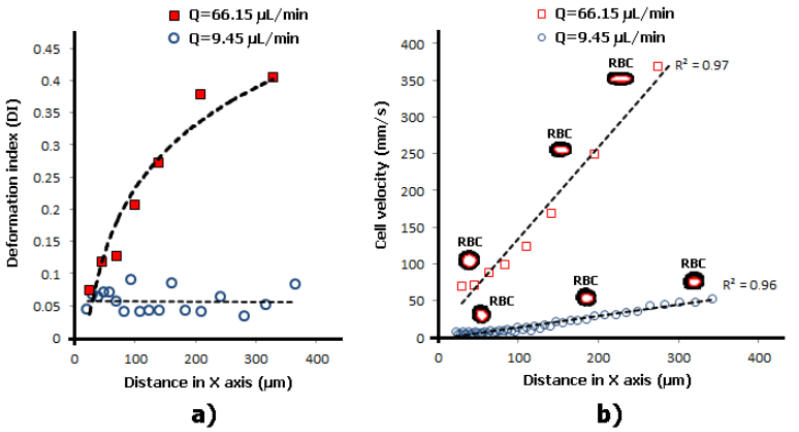
Figure 4. Individual RBCs’ ( a ) DI and ( b ) velocity flowing through a hyperbolic contraction microchannel for two different flow rates: 9.45 µ L/min and 66.15 µ